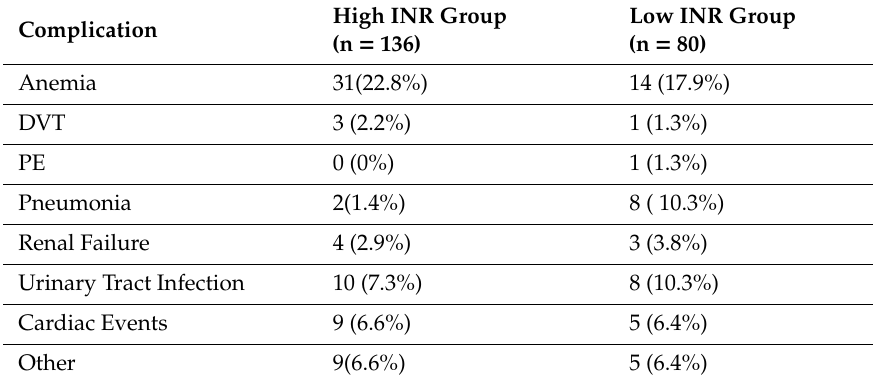
Table 2. Di ff erences in the type of